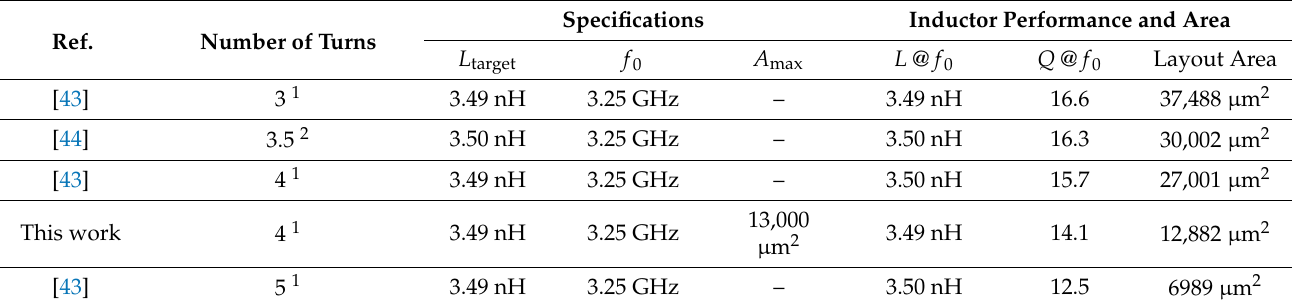
Figure 8. Frequency characteristics of the on-chip inductors designed by different methods: this work (black), 1st iteration of customized enumeration (green), 2nd iteration of customized enumeration (blue), ISM (violet). Horizontal and vertical solid red lines denote the target inductance and the operating frequency, respectively. Table 8. Comparison of different design